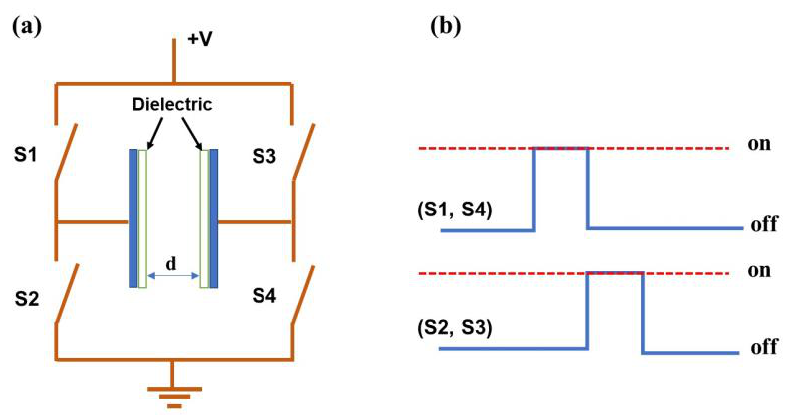
Figure 2. Schematic drawing of plasma generation DBD. ( a ) High-voltage H-bridge to switch polarity between electrodes with the electrode distance d. ( b ) The pulse sequence used to control H- bridge.